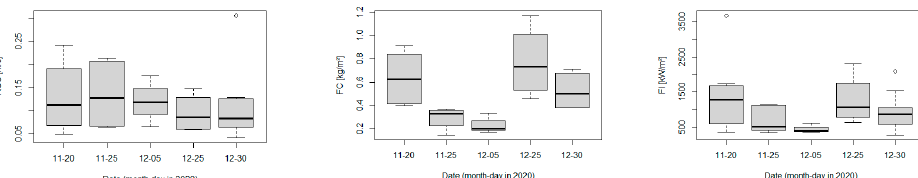
Figure 6. Boxplots of ROS (left), FC (middle) and FI (right) of the analyzed fire clusters. ROS and FI values represent the means of the 90% quantiles of the fire spread vectors over the different fire clusters. Number of observations are: 11-20:8, 11-25:6, 12-05:3, 12-25:4, 12-30:9.